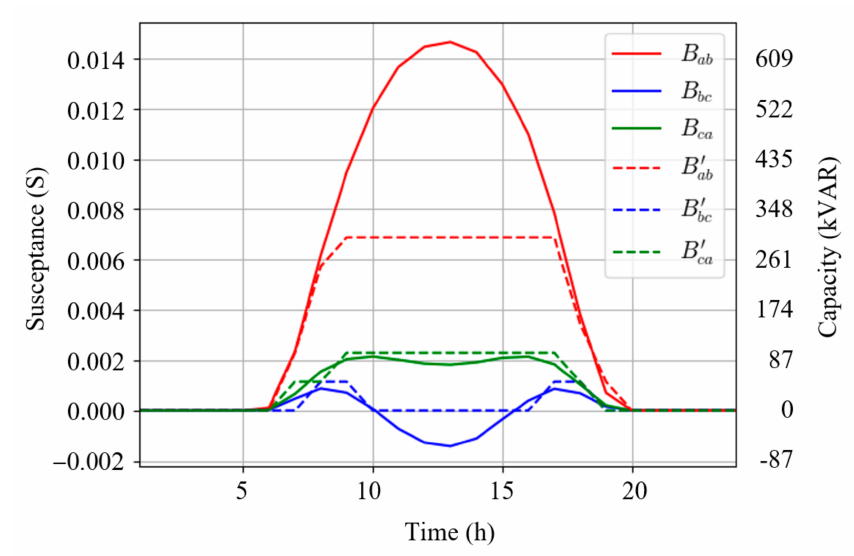
Figure 14. Time variation in susceptance of single-phase reactors.